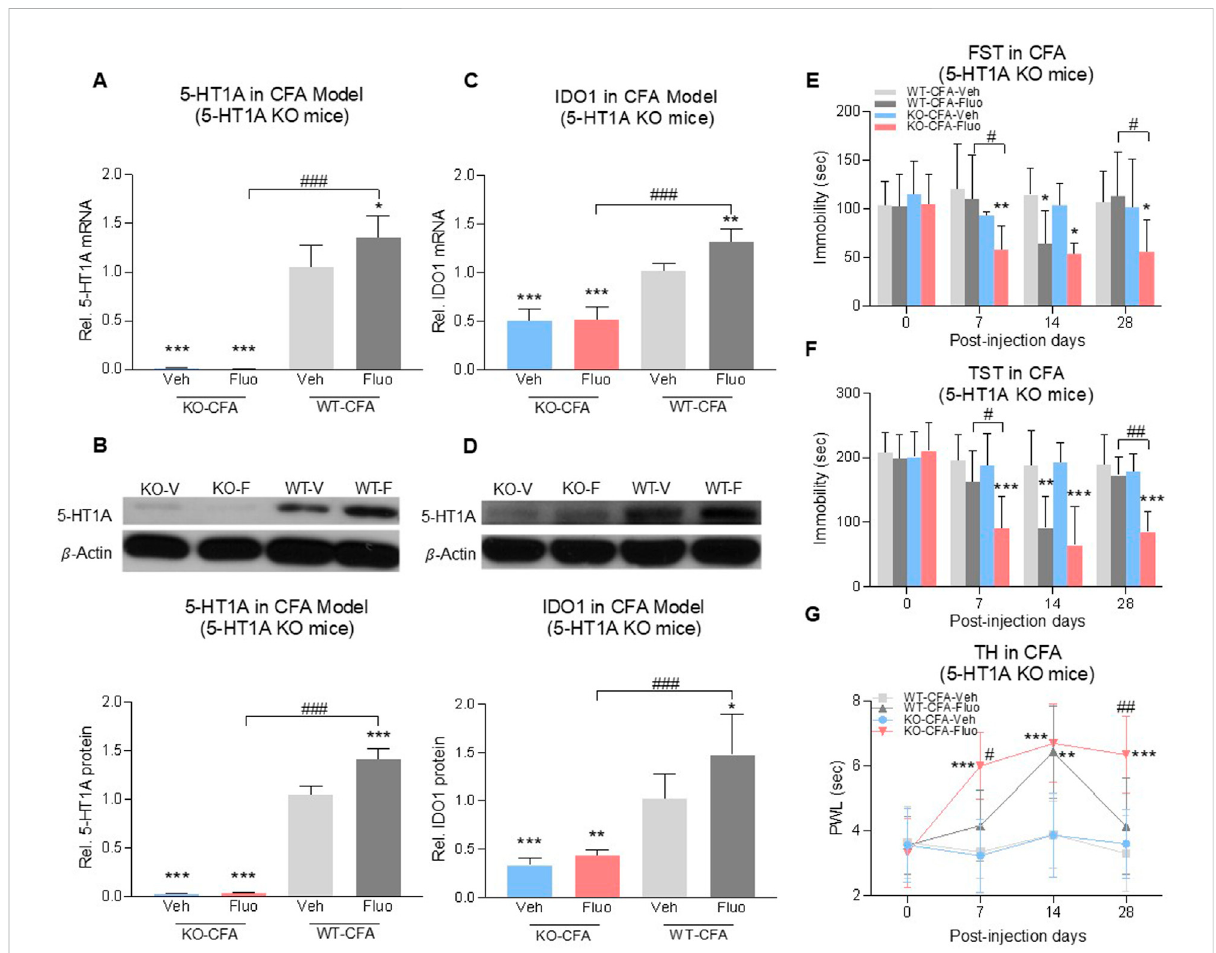
FIGURE 5 Fluoxetine maintained its antidepressant and analgesic effects in 5-HT1A receptor-KO mice. Fluoxetine increased 5-HT1A receptors (A,B) and IDO1 (C,D) inWT-CFAmodelmice(WT-Vehvs.WT-Fluo),whilehadnoeffectonKO-CFAmodelmice(KO-Vehvs.KO-Fluo). (A,B) 5-HT1Areceptors were absent in 5-HT1A receptor-KO mice (WT-Veh vs. KO-Veh, KO-Fluo). (C,D) 5-HT1A receptor-KO decreased IDO1 expression in the DRN (WT- Veh vs. KO-Veh, KO-Fluo). In the CFA model, fl uoxetine decreased the immobility time (E,F) and increased PWL (G) in 5-HT1A receptor-KO mice as early as day 7 (WT-Veh vs. KO-Fluo), as compared to only on day 14 in WT mice (WT-Veh vs. WT-Fluo). 5-HT1A KO maintained chronic fl uoxetine antidepressant and antihyperalgestic effects up to day 28 (WT-Fluo vs. KO-Fluo). There was no difference between vehicle-treated KO and vehicle-treated WT mice. The data are presented as mean ± SD ( n = 6). * p < 0.05, ** p < 0.01 and *** p < 0.001 vs. WT-Veh; # p < 0.05, ## p < 0.01 and ### p < 0.001, WT-Fluo vs. KO-Fluo. Rel. Indicates relative; Veh, vehicle; Fluo, fl uoxetine; WT, wild type; FST, forced swim test; TST, tail suspension test; TH, thermal test; PWL, paw withdrawal